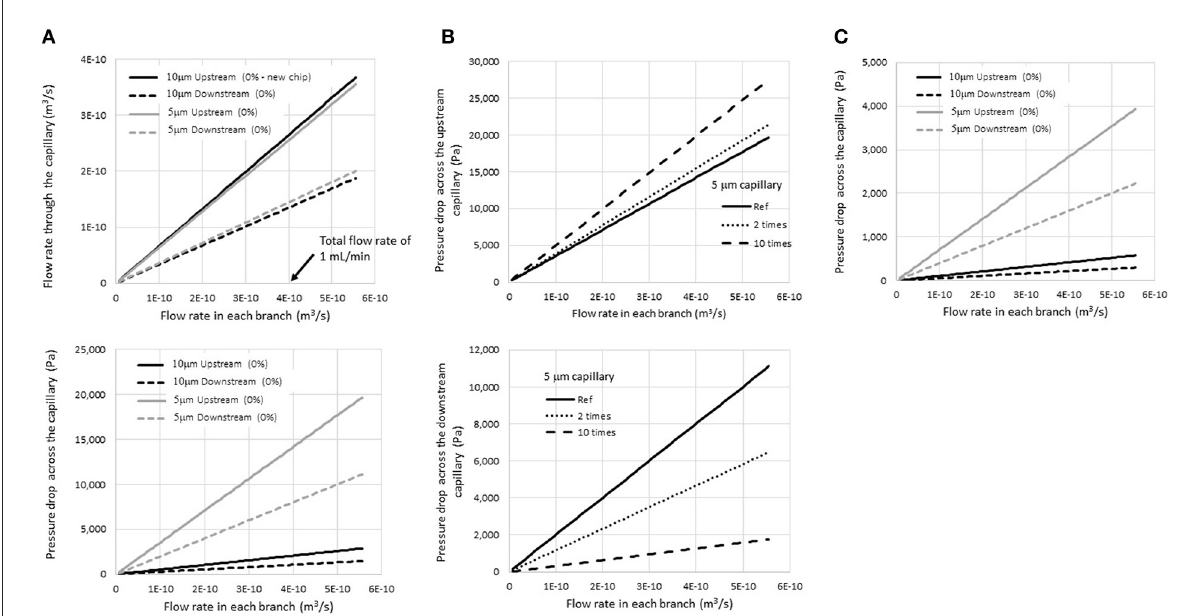
FIGURE4 Simulation results of (A) the flow rate and pressure drop across the upstream and downstream capillary for a given total injecting flow rate for 5- and 10- µ m-wide capillaries, (B) the pressure drop at the 5- µ m upstream and downstream capillary when the flow resistance increase due to the accumulation of blood cells in the inlet flow passage. The calculation assumed a two-fold and ten-fold increase in flow resistance, and (C) the pressure drops when the viscosity was reduced